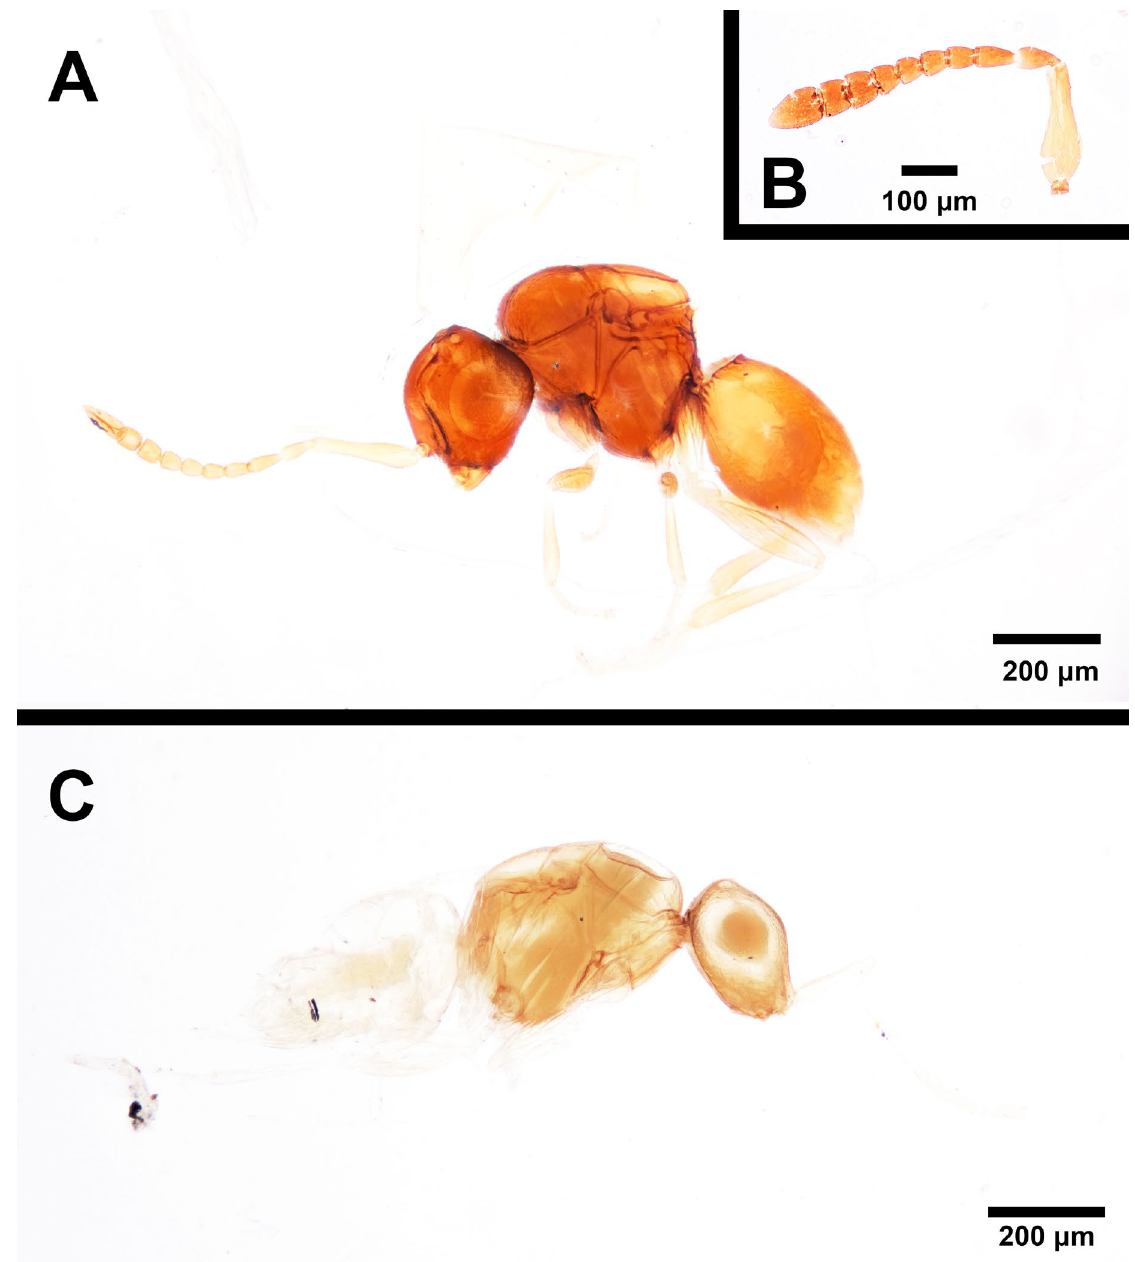
Fig. 7. A . Aphanogmus origenus (kieffer, 1913), lectotype, ♀, lateral view (MNhN EY25358). B . Left antenna of the female lectotype (MNhN EY22436). C . The last Ceraphron origenus kieffer, 1913, paralectotype that Dessart determined to be a different species of Aphanogmus , possibly a new species (MNhN